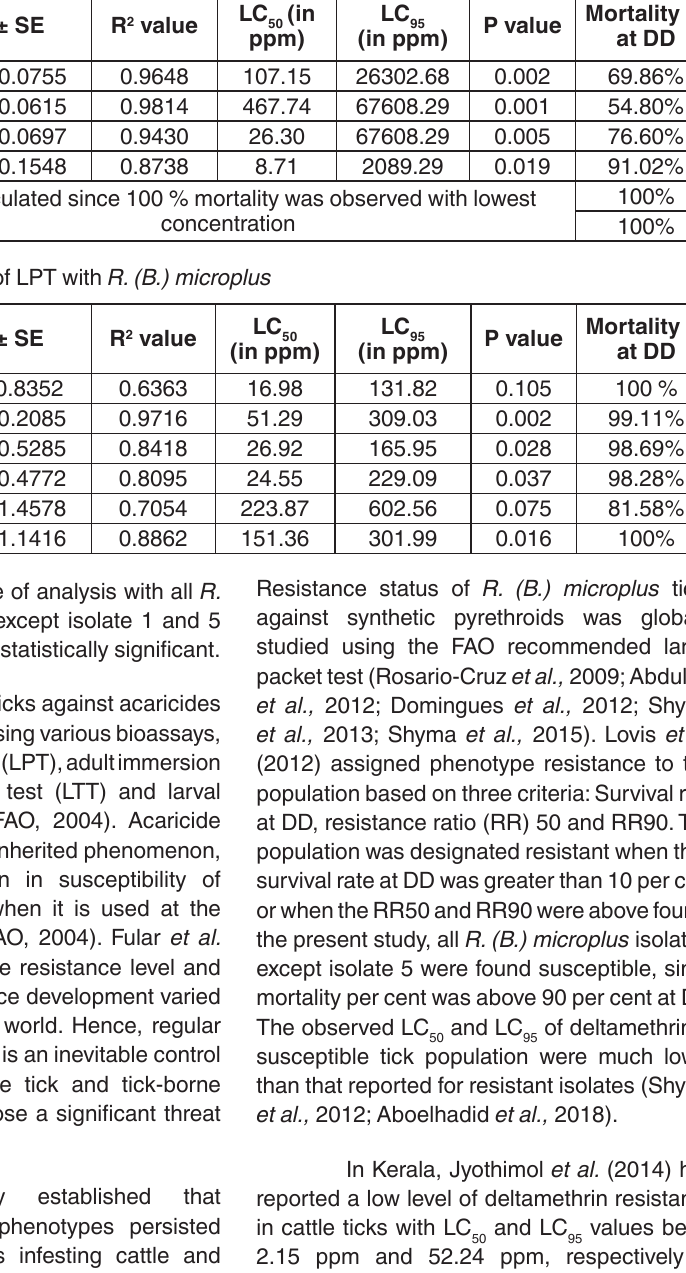
table 1 Probit analysis of LPT with R. sanguineus tick slope ± se r 2 value Isolate 1 0.6742 ± 0.0755 0.9648 Isolate 2 0.7624 ± 0.0615